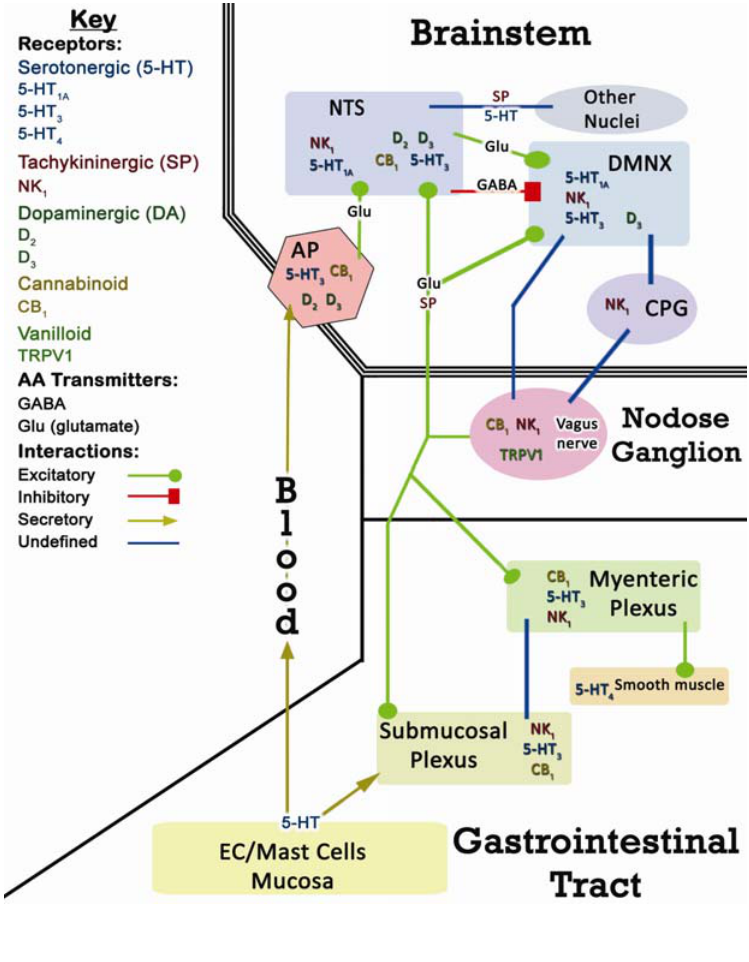
Figure 1. Overview of neurotransmitter systems involved in the emetic reflex. Numerous receptors are present in emetic loci, but only well-established receptor localizations are depicted. The cholinergic system has also been omitted since it does not play a role in mediating CINV. Many connections in the emetic reflex [e.g. the central pattern generator (CPG)] are not well-defined anatomically and/or physiologically (blue lines). EC – intestinal enterochromaffin